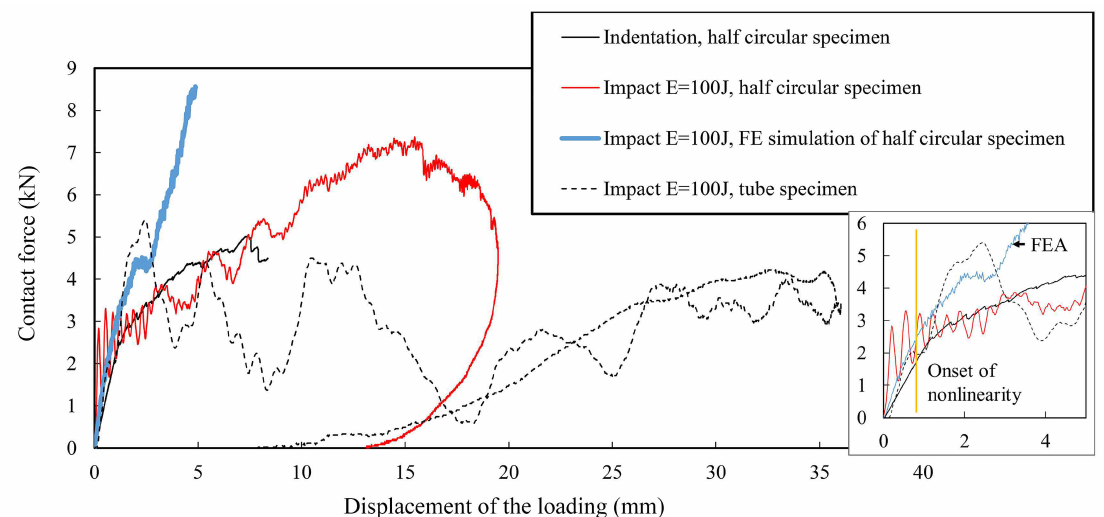
Figure 9. The performance of the GFRP laminate and tube: the contact force-displacement response based on experiments and FEA (linear material [27]). The inset graph on the right shows the detailed data at the beginning of the tests/analyses and predicted displacement level for damage